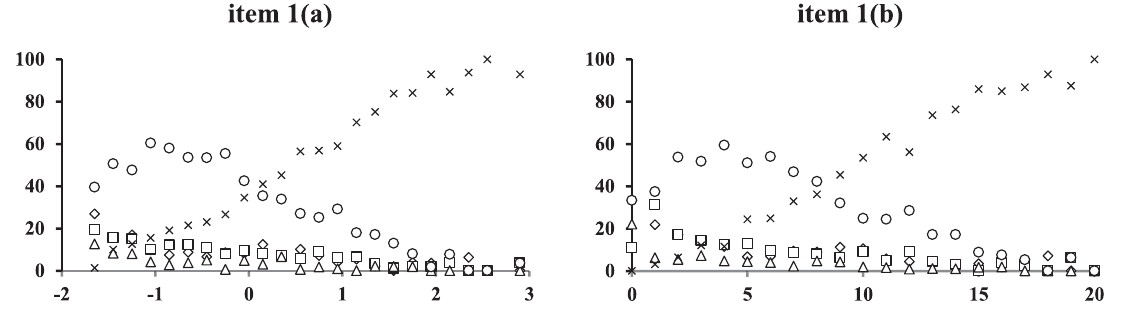
FIG. 5. The IRC of item 1, showing the percentage of respondents by choice, with symbols for the choices being ⋄ ¼ A, □ ¼ B, Δ ¼ C, o ¼ D, and × ¼ E. The correct choice was E. The horizontal scale is the ability in plot 1(a), and the total test score in plot 1(b).